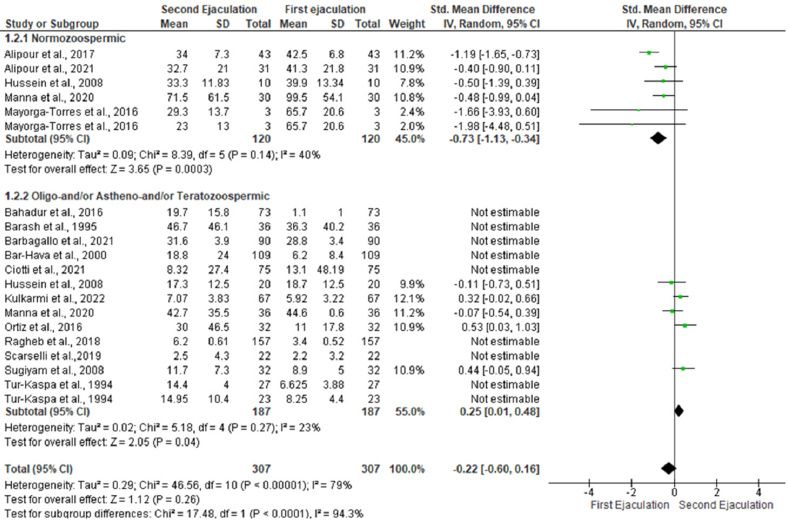
Figure 3. Forest plot of studies that evaluated the effects of a very short abstinence period on sperm concentration (expressed in mil/mL). The following studies were included in the quantitative analysis (in order of appearance in the manuscript): Manna et al., 2020 [16], Bahadur et al., 2016 [17], Ortiz et al., 2016 [18], Alipour et al., 2017 [19], Ragheb et al., 2018 [20], Ciotti et al., 2021 [22], Tur- Kaspa et al., 1994 [27], Barash et al., 1995 [28], Bar-Hava et al., 2000 [29], Sugyam et al., 2008 [30], Hussein et al., 2008 [31], Mayorga-Torres et al., 2016 [32], Scarselli et al., 2019 [33], Alipour et al., 2021 [34], Barbagallo et al.,2021 [35], and Kulkarmi et al., 2022 [36].